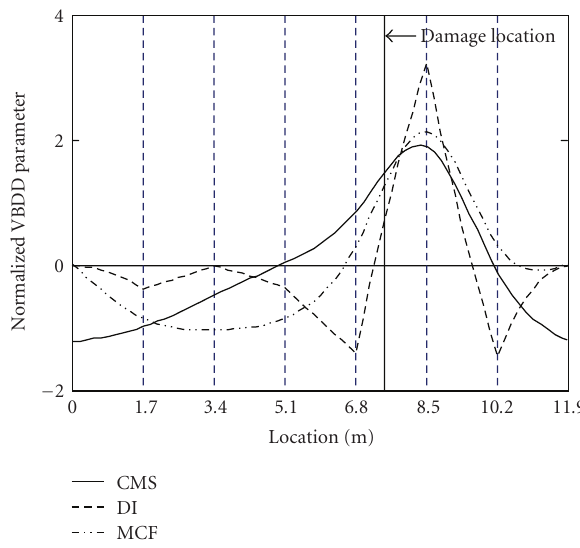
Figure 5: Distributions of normalized VBDD parameters for experimental damage case